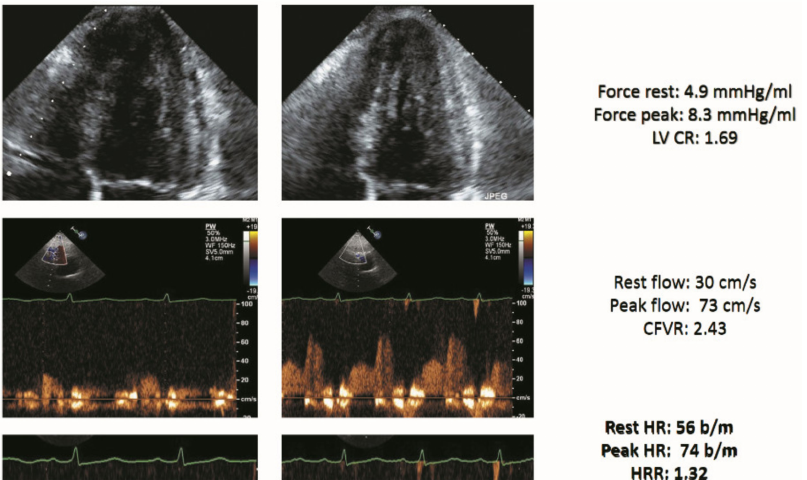
Figure 1. Stress echo with a normal score of 0 in a patient with heart failure (HF). Left column: rest. Right column, stress. From top to bottom: normal end-systolic volume at rest which decreased during stress (force rest = 4.9 mm Hg/mL; stress = 8.3 mm Hg/mL) with a normal LVCR (1.69); normal increase of pulsed-wave Doppler peak diastolic flow (rest = 30 cm/s; stress = 73 cm/s; CFVR = 2.43); normal heart rate reserve: heart rate rest = 56; peak = 74 bpm; heart rate reserve (74/56) = 1.32. Abbreviations: CFVR, coronary flow velocity reserve; EKG, electrocardiogram; HRR, heart rate reserve; LAD, left anterior descending coronary artery; LV, left ventricle; LVCR, left ventricular contractile